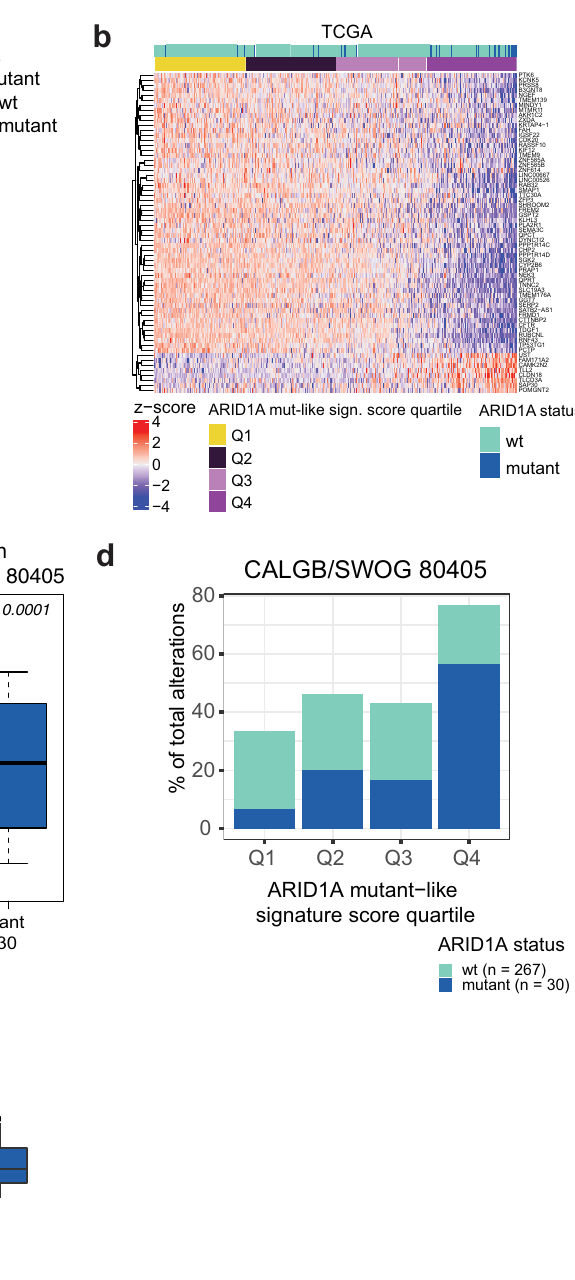
p < 0.0001p < 0.001